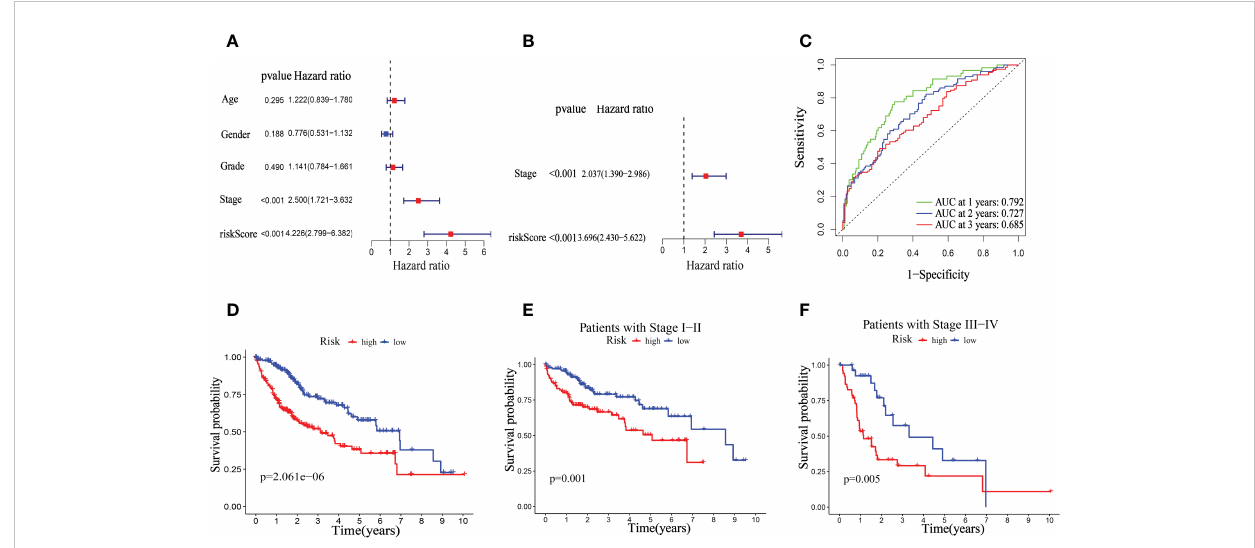
FIGURE 8 Univariate and multivariate Cox regression analyses for OS in the TCGA train group. Univariate (A) and multivariate (B) Cox regression analysis of riskScore and clinicopathological parameters in TCGA dataset. (C) Time-dependent ROC curve of riskScore. (D) Kaplan – Meier analysis between riskScore-de fi ned groups. (E) Kaplan – Meier analysis between riskScore-de fi ned groups in patients with stage I-II. (F) Kaplan – Meier analysis between riskScore-de fi ned groups in patients with stage III-IV.